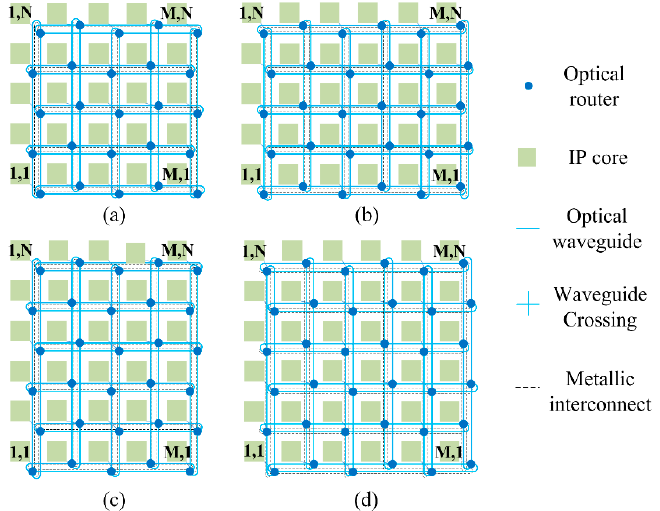
Figure 4. WDM-based torus optical networks-on-chip (ONoCs): ( a ) M and N are both odd numbers; ( b ) M is an even number and N is an odd number; ( c ) M is an odd number and N is an even number; ( d ) M and N are both even numbers.